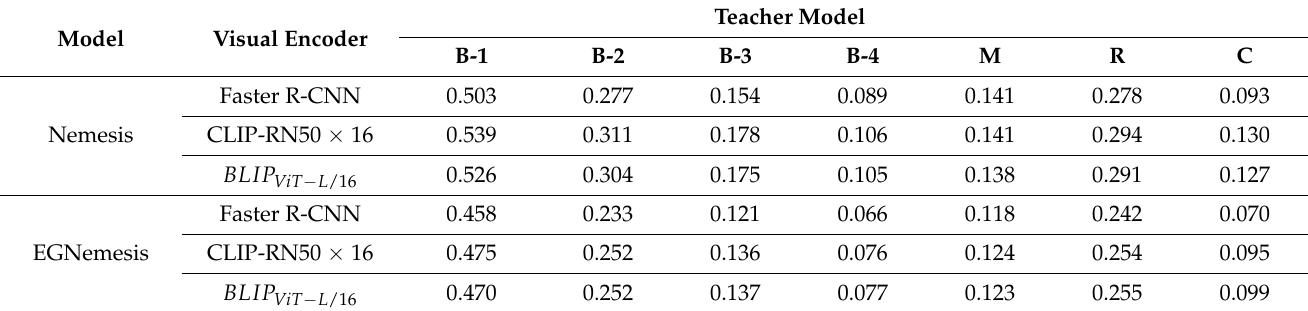
Table 1. Performance of the teacher model utilizing different visual encoders for both the Nemesis and EGNemesis models. (B: BLEU, M: METEOR, R: ROUGE, C: CIDEr).